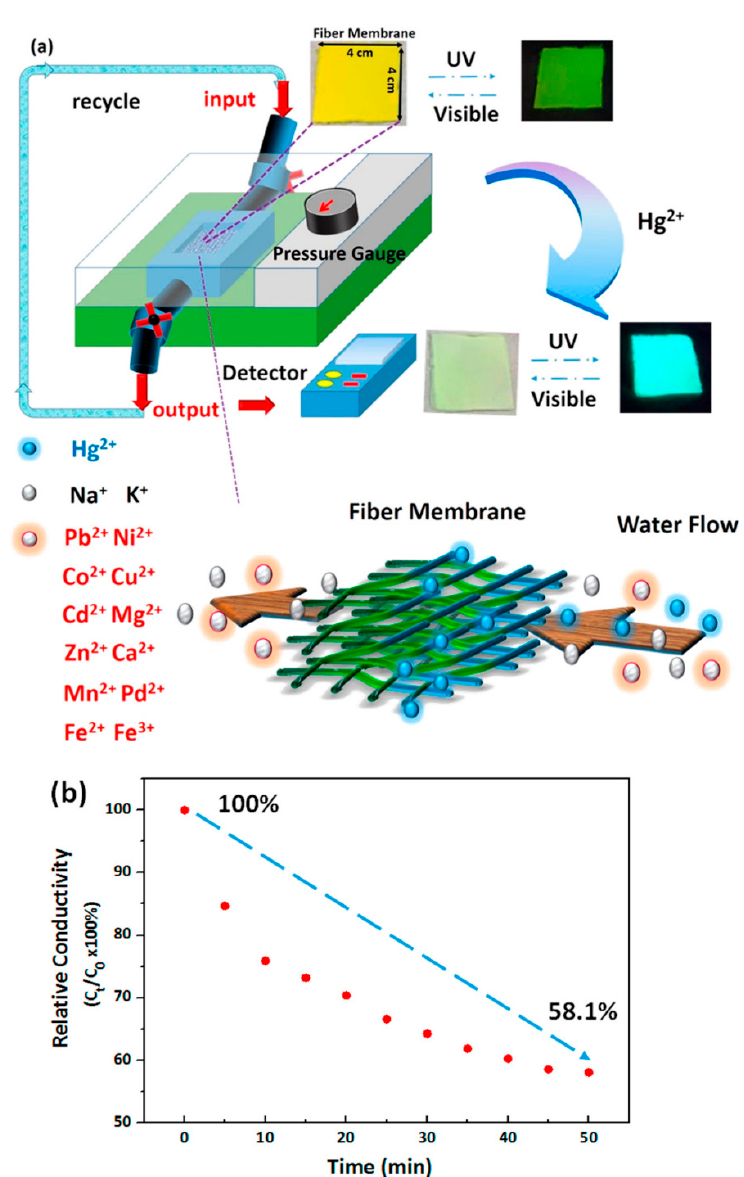
Figure 5. ( a ) Schematic illustration of a probe filter microfluidics system for real-time metal-ion sensing using an electrospun nanofiber membrane. ( b ) Relative conductivity versus time of the prepared Hg 2